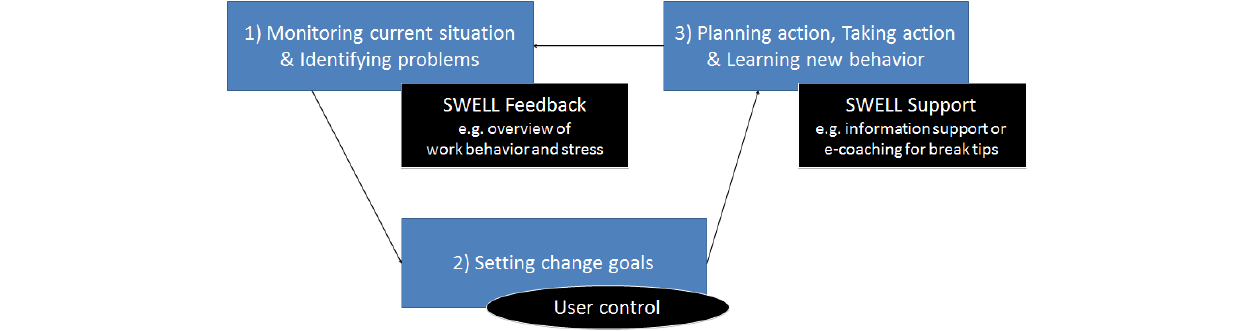
Figure 9. Behavior change and how technology could support